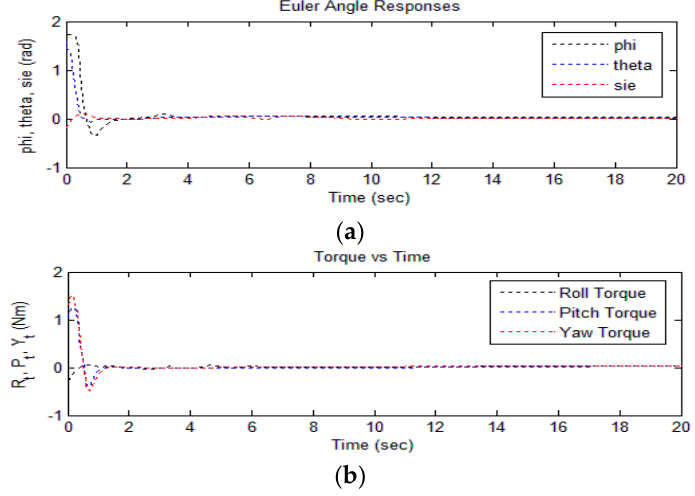
Figure 8. ( a ) The roll, pitch, yaw rate, and Euler angle responses of UAV; ( b ) torque with respect to the Euler angle response of UAV.